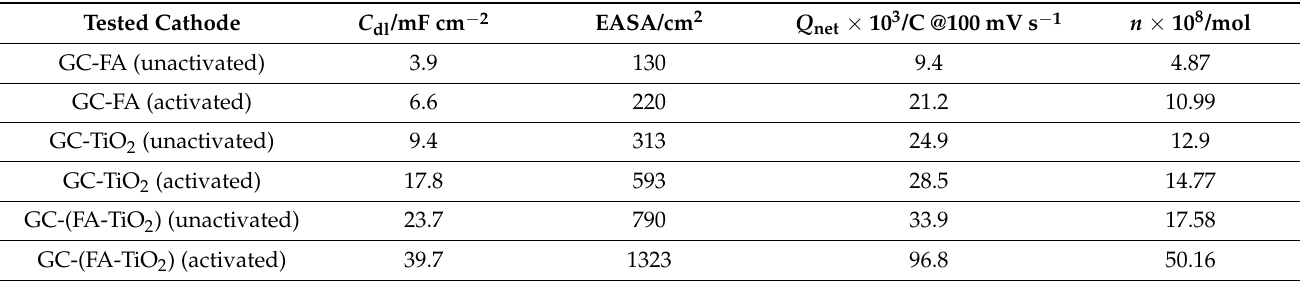
Table 3. Double-layer capacitance ( C dl ), electrochemical active surface area (EASA), net voltammetry charge ( Q ), and the number of active sites ( n ) estimated for the investigated electrocatalysts from CV